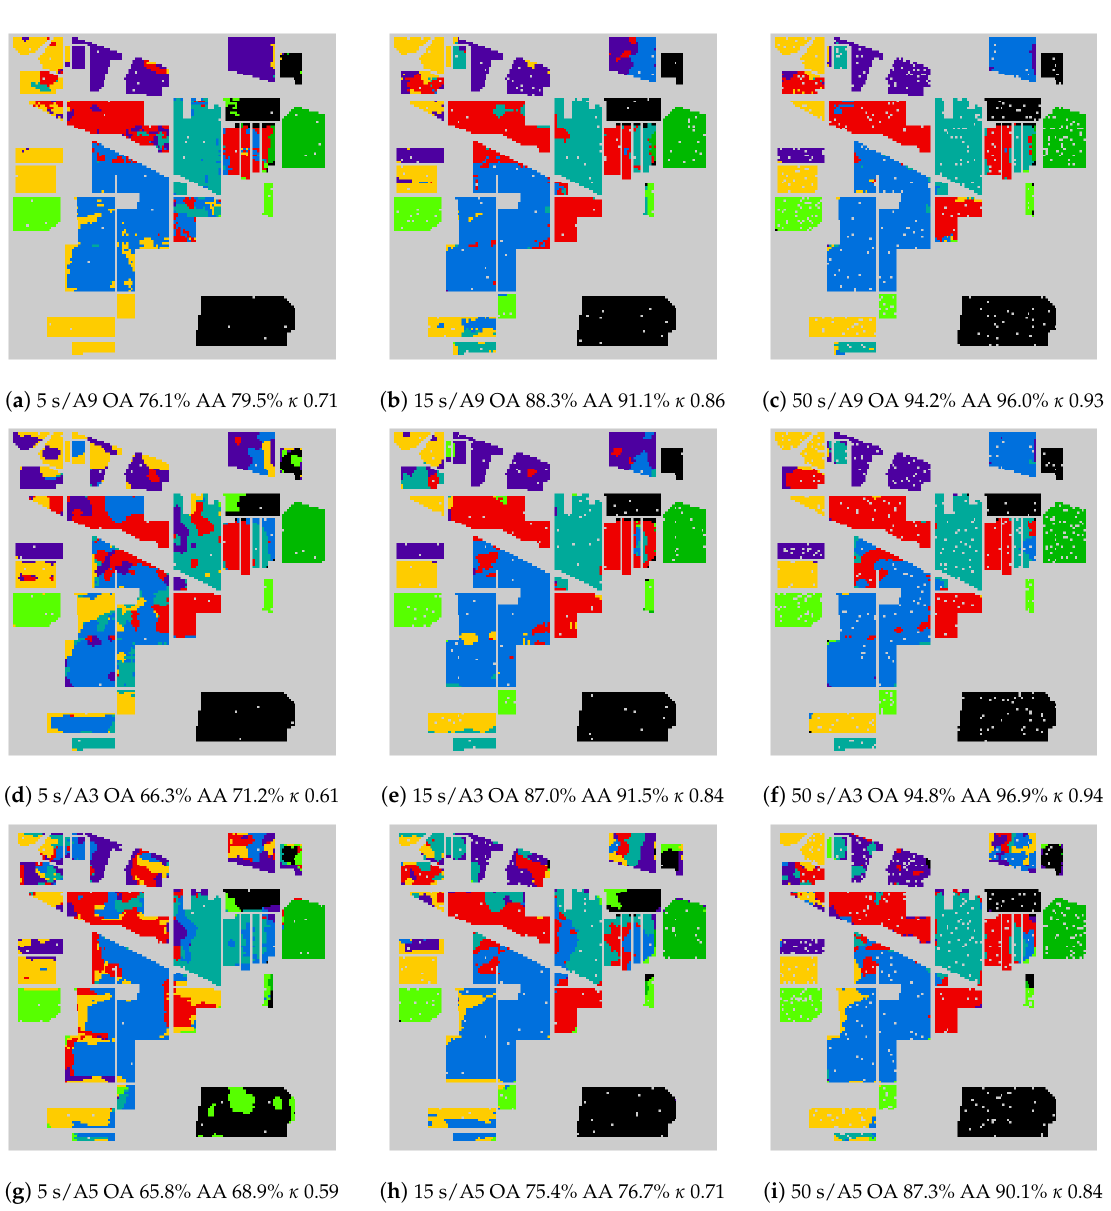
Figure 4. Sample results from experiment one, Indian Pines dataset. Rows present the three examined architectures, where A9, A3 and A5 corresponds to architectures [15,16,63], respectively. Columns present the three cases of number of true training samples per class in fine-tuning (5 s, 15 s, and 50 s). For each result, the Overall Accuracy (OA), Average Accuracy (AA), and κ coefficient are reported. Isolated grey points mark locations of the training samples, and are excluded from the